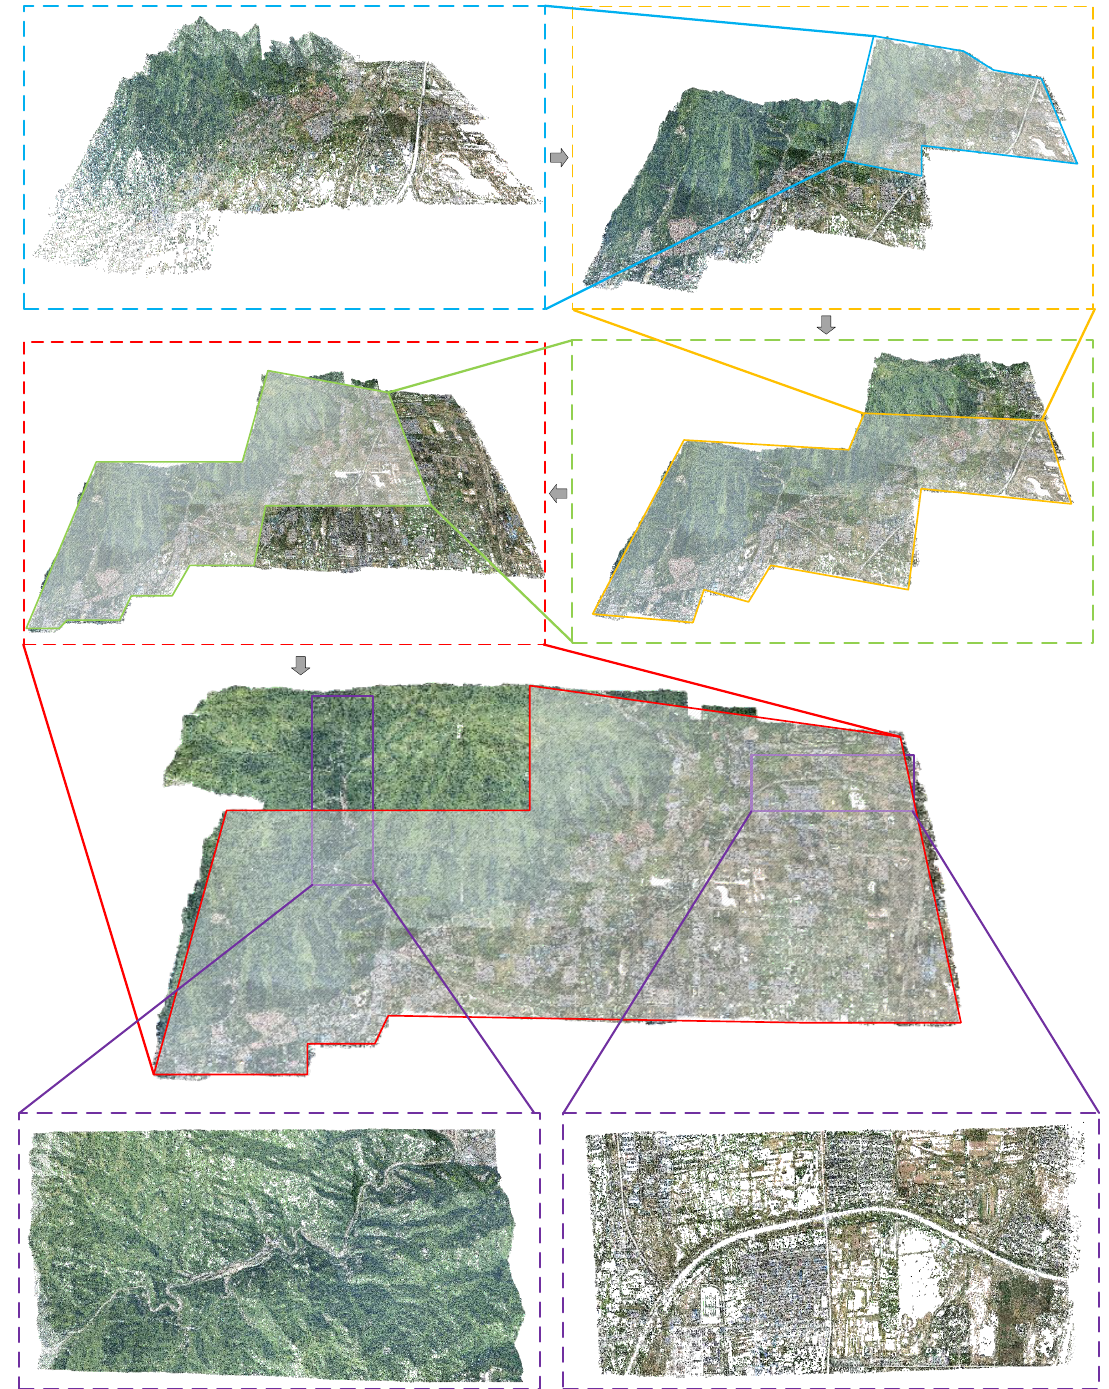
Figure 8. Example of the partial scene structure dynamic merging process on the Qinling dataset. The gray shaded area represents the reconstructed scene before the next fusion. The purple dotted box denotes the magnification of the fusion